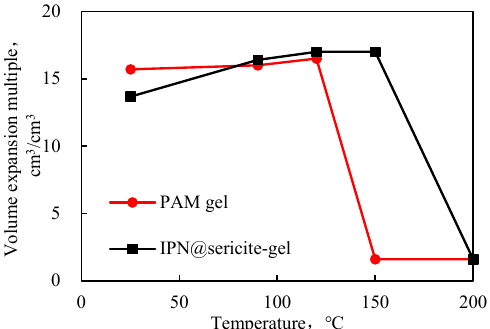
Figure 7. Equilibrium swelling factor at different temperatures. Based on the results of the water absorption expansion temperature at different tem- peratures, the viscoelasticity of the material after water absorption and swelling at 150 °C was tested. The fixed shear modulus was 0.5%, and the testing time was fixed at 10 s with an angular frequency of 0.1–100 rad/s. The experimental results were compared with the viscoelasticity model of the sample after water swelling at 25 °C and the results are pre- sented in Figure 8. was improved from 120 ◦ C to 150 ◦ C by 25%.